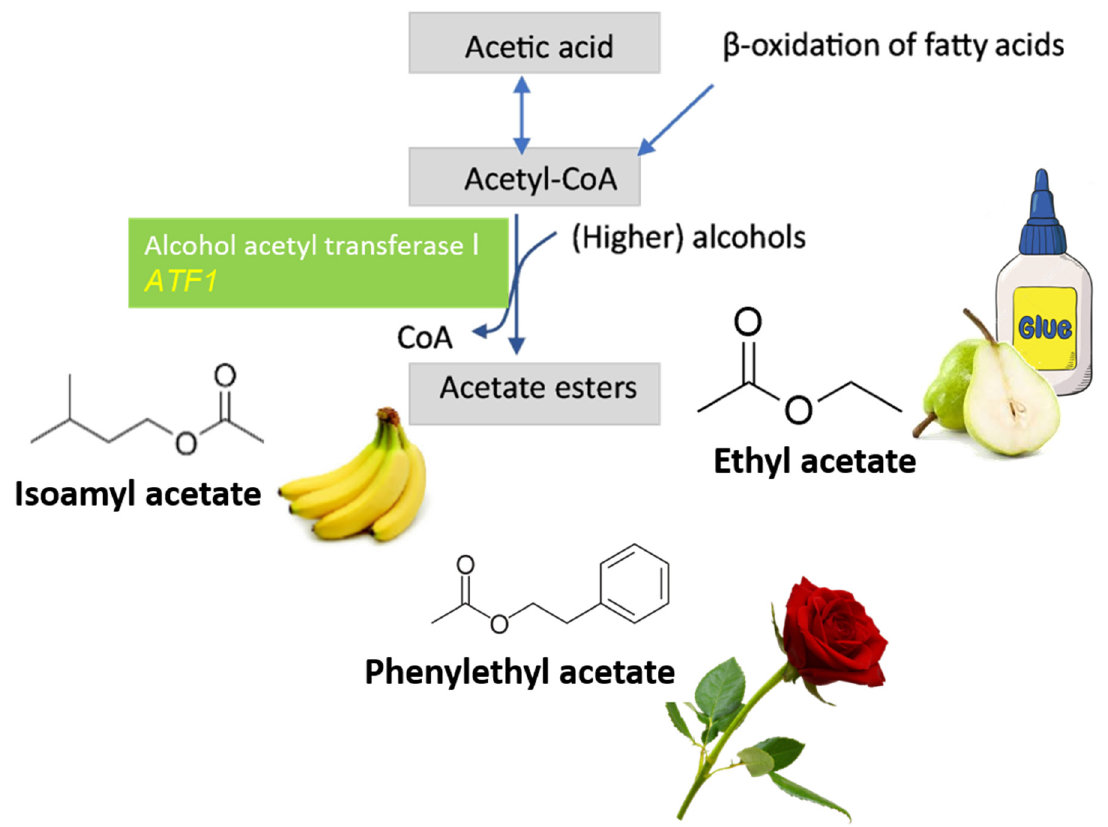
Figure 6. For ATF1 overexpression, acetyl-CoA is condensed with alcohols to form acetate esters. As more acetate esters are produced, much less acetyl-CoA is available to convert to acetic acid.